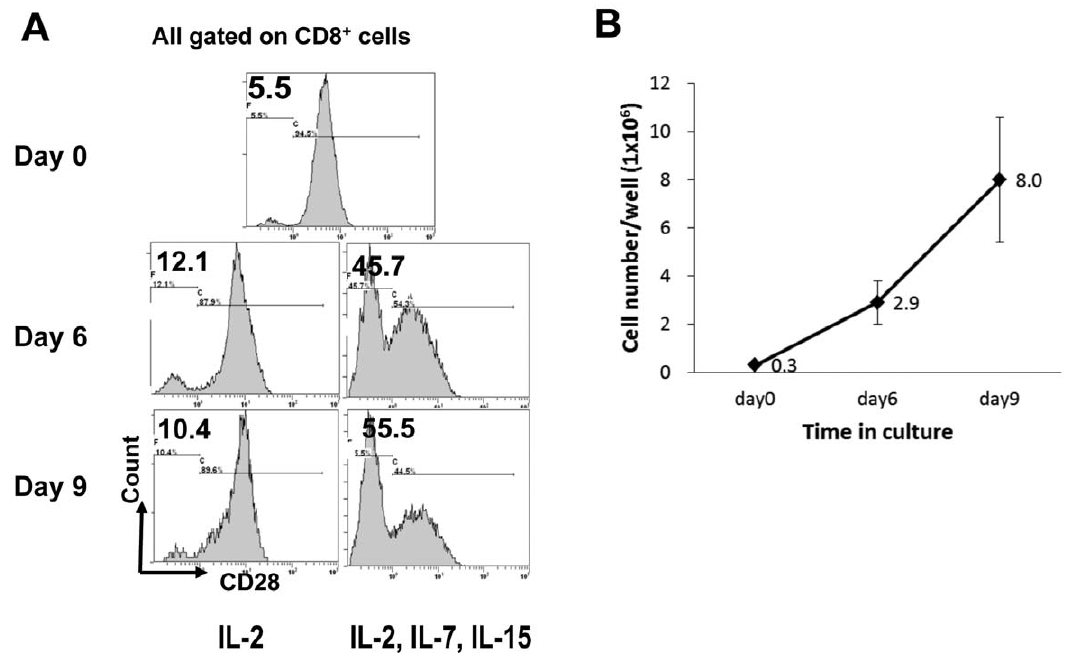
Figure 1. Donor APCs plus c c cytokines induce rapid expansion of CD8 + CD28 2 T cells in culture. Freshly purified CD8 + T cells (2 6 10 6 per well) from healthy volunteers were stimulated by HLA-A, B and DR mismatched allogeneic APCs (1 6 10 6 per well) for 9 days in 24-well plates supplemented with IL-2 alone or a combination of IL-2, IL-7 and IL-15. A , Expression of CD28 on CD8 + cells over time. Histograms were gated on the CD8 + population. B , Expansion of cell numbers of the CD8 + CD28 2 population over time by donor APC plus c c cytokines stimulation. The numbers of the CD8 + CD28 2 cells per well of 24-well culture plates were calculated for day 0, 6 and 9. Data shown in A are representative of three independent experiments. Data shown in B is the average of three independent experiments.